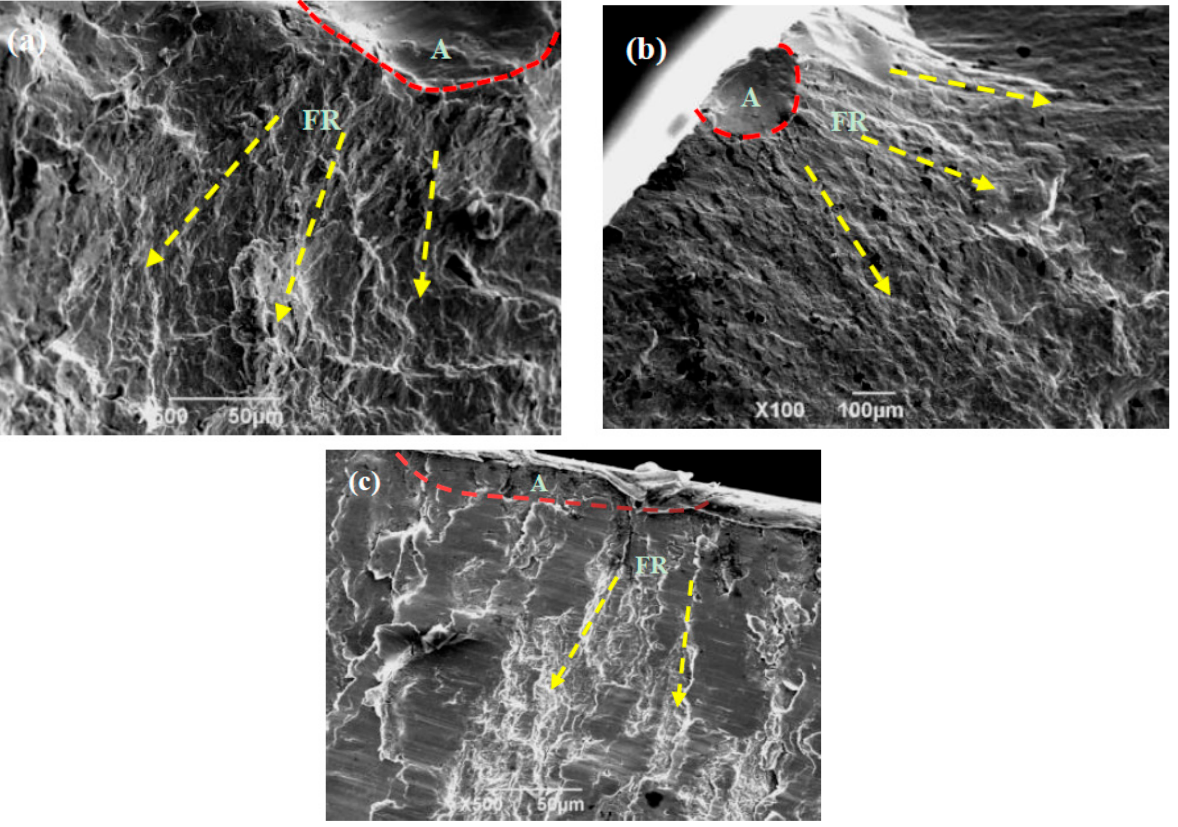
Figure 11. Fracture morphologies of fatigue crack initiation region under 90° non-proportional tension–torsion loading at different stress amplitudes. ( a ) S eq = 458.6 MPa, ( b ) S eq = 509.6 MPa, ( c ) S eq = 622.4 MPa. ‘A’ represents fatigue initiation zone and ‘FR’ represents fatigue radiation.